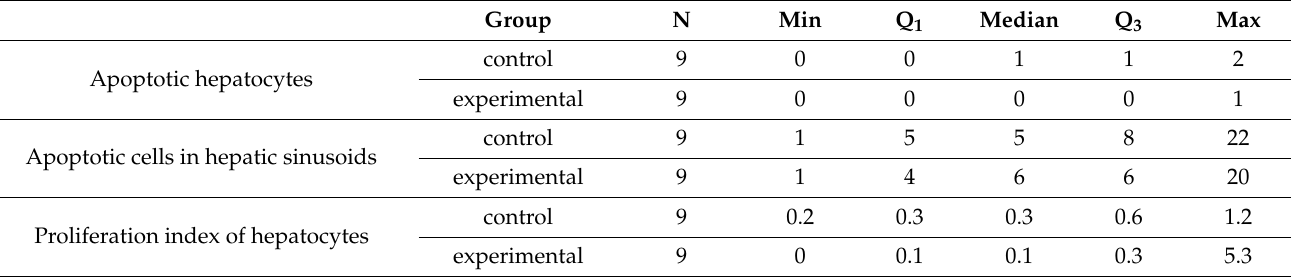
Table 4. The cumulative number of apoptotic cells and the proliferation index of hepatocytes in the liver of control and experimental piglets presented with basic descriptive statistics.